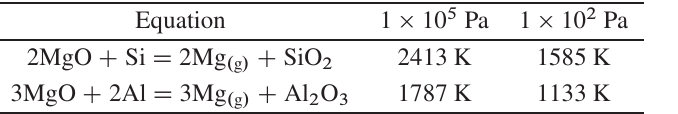
Table 2. Constituents of fluxes (mass %).